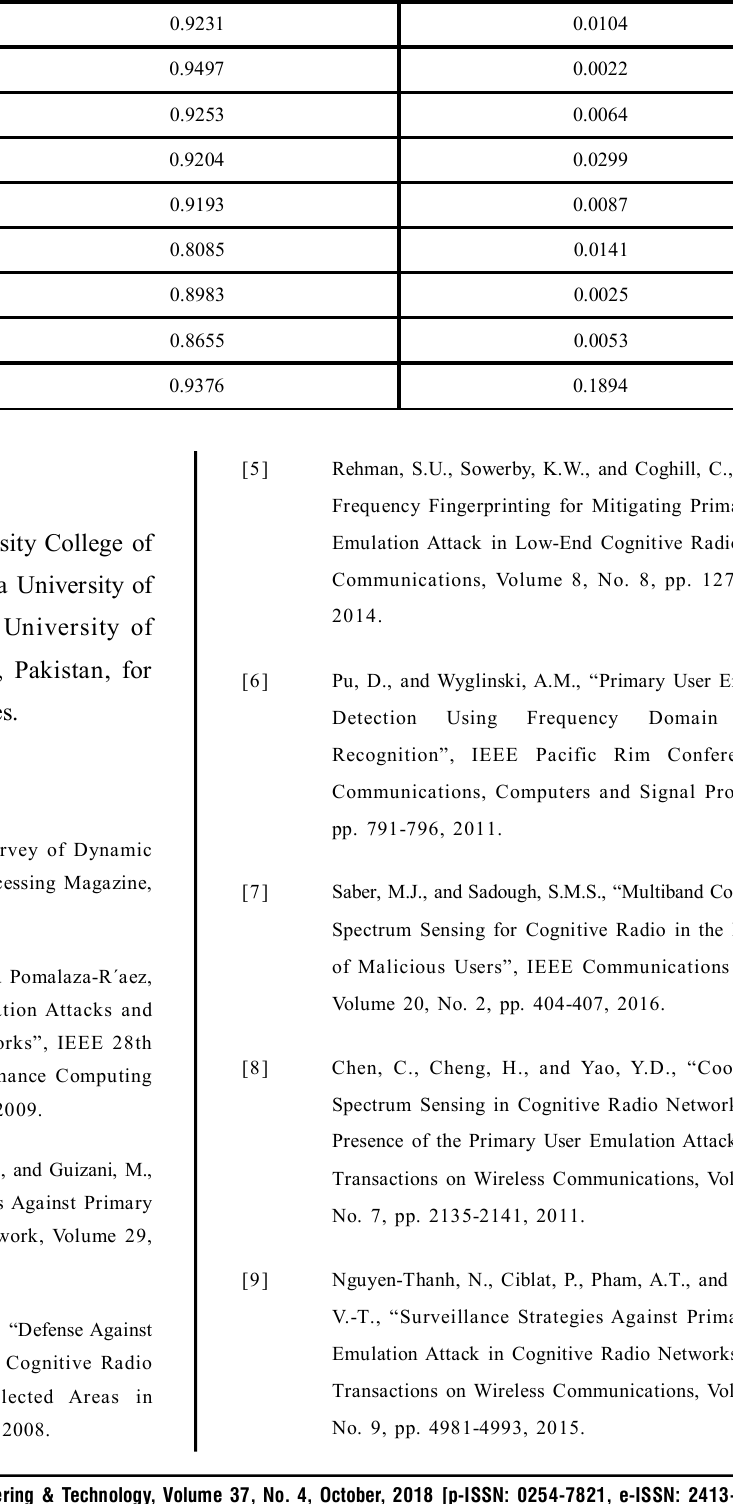
TABLE 2. CORRELATION VALUES FOR THE ORIGINAL AND ENCRYPTED IMAGES SHOWN IN FIGS. 3-5